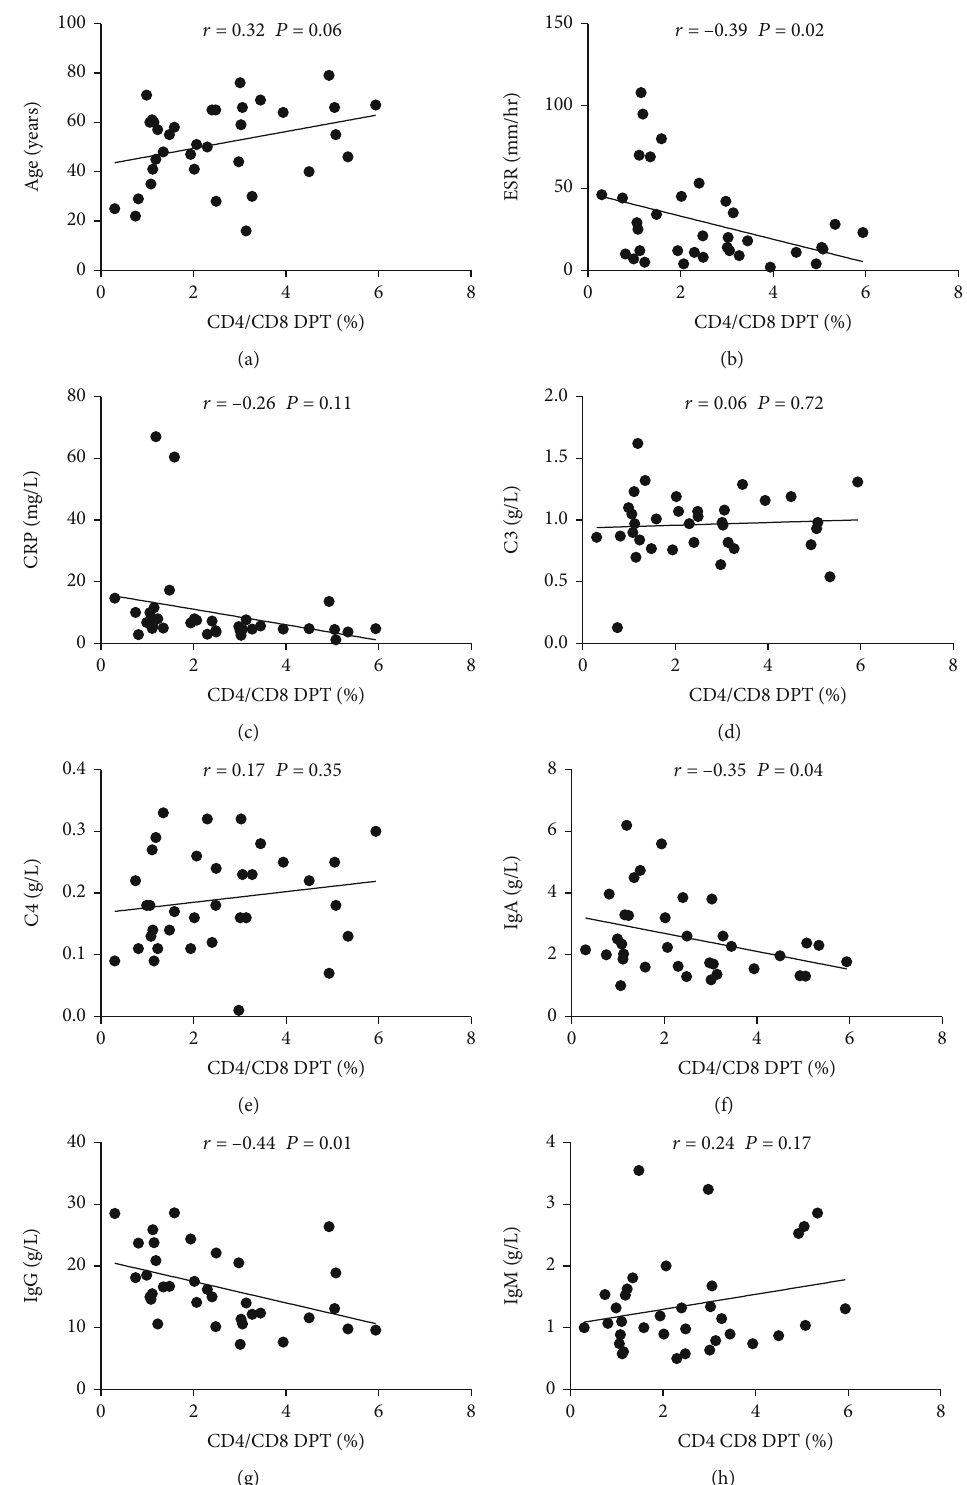
Figure 2: Correlation between frequency of peripheral DPT cells and clinical parameters. (a – h) Correlation of peripheral DPT cells with age, ESR, CRP, C3, C4, IgA, IgG, and